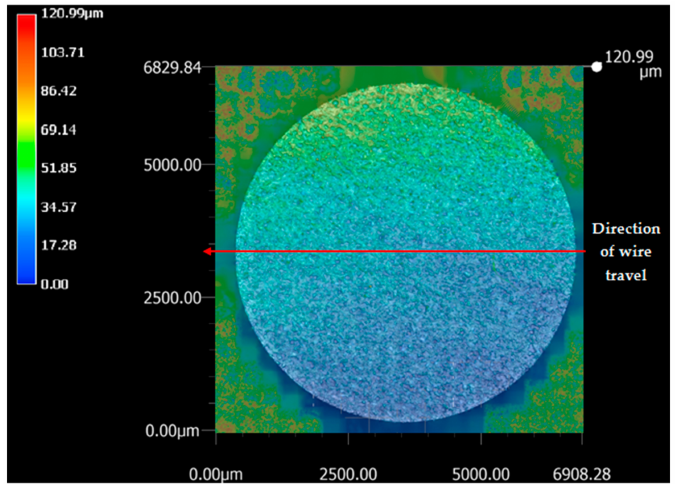
Figure 3. Surface machined under optimized process